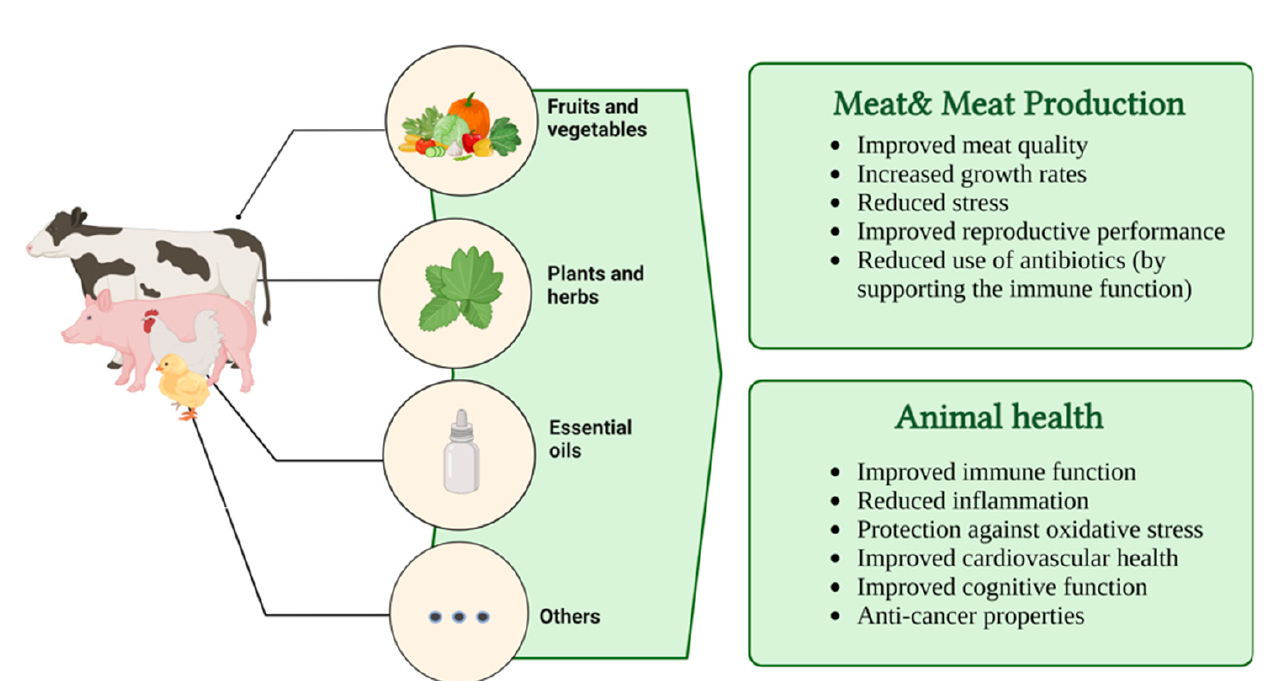
Figure 3. Natural antioxidant dietary supplementation effects (illustration made via www.BioRender.com, accessed on 9 March 2023).